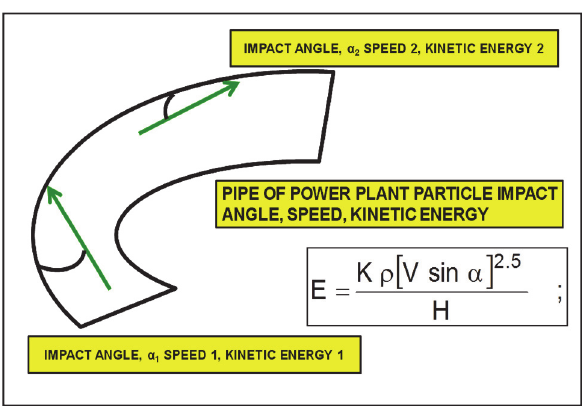
Fig. 16. Concept of usage of a mathematical model in a pipe during a stream of erodent particles. The impact particle, kinetic energy, speed, and impact angle variations along curved pipe regions determine constraints for modelling. The formula that is set in the sketch corresponds to Eq.